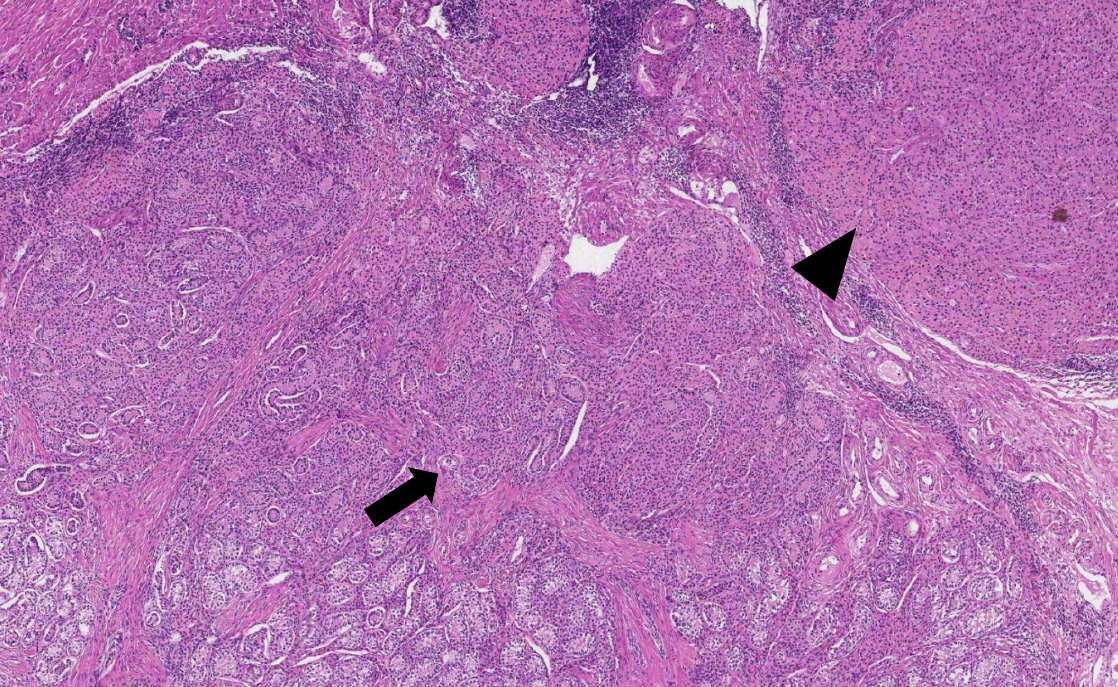
Figure 5. Small tubules composed of immature Sertoli cells separated by Leydig cells (arrow) and nodular Leydig cell hyperplasia (arrowhead) (H&E staining, ×50).